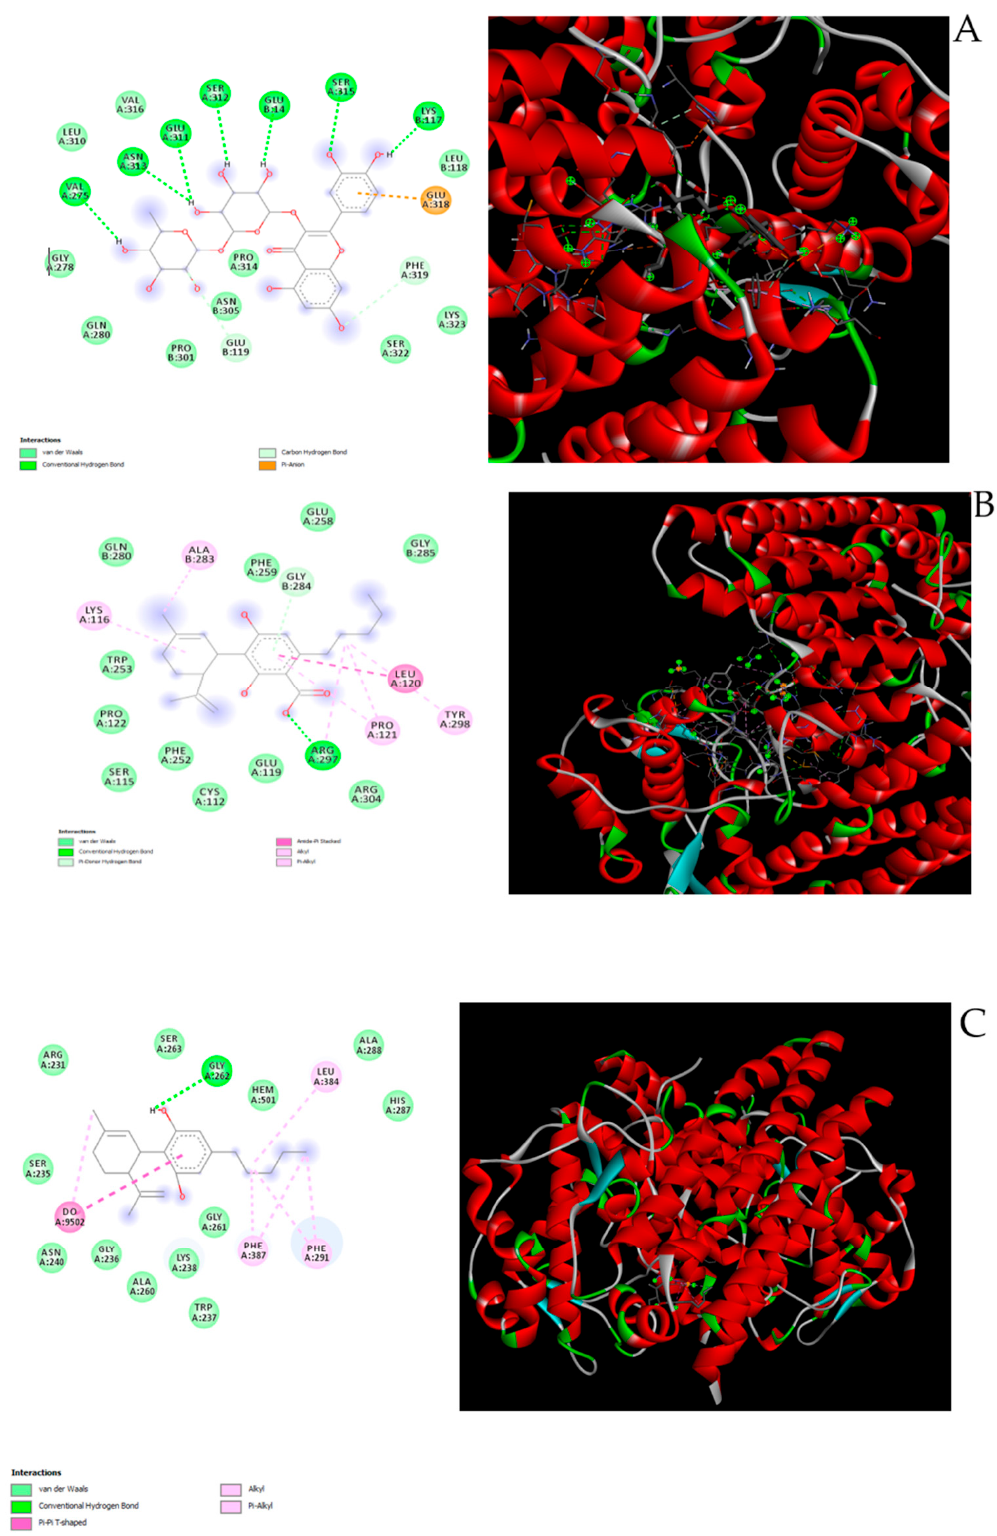
Figure 10. ( A ) Putative interactions between rutin and indoleamine-2,3-dioxygenase (IDO-1; PDB: 6KOF). Free energy of binding ( Δ G) and a ffi nity (Ki) are − 9.2 kcal/mol and 0.2 µM, respectively; ( B ) putative interactions between cannabidiolic acid and indoleamine-2,3-dioxygenase (IDO-1; PDB: 6KOF). Free energy of binding ( Δ G) and a ffi nity (Ki) are − 7.6 kcal/mol and 2.7 µM, respectively. ( C ) Putative interactions between cannabidiol and indoleamine-2,3-dioxygenase (IDO-1; PDB: 6KOF). Free energy of binding ( Δ G) and a ffi nity (Ki) are − 7.4 kcal/mol and 3.8 µM, respectively. On the other hand, the docking runs yielded a good affinity towards tyrosinase (0.8 µM) for the sole rutin (Figure 11A–C). On one side, this is consistent with the concentra-